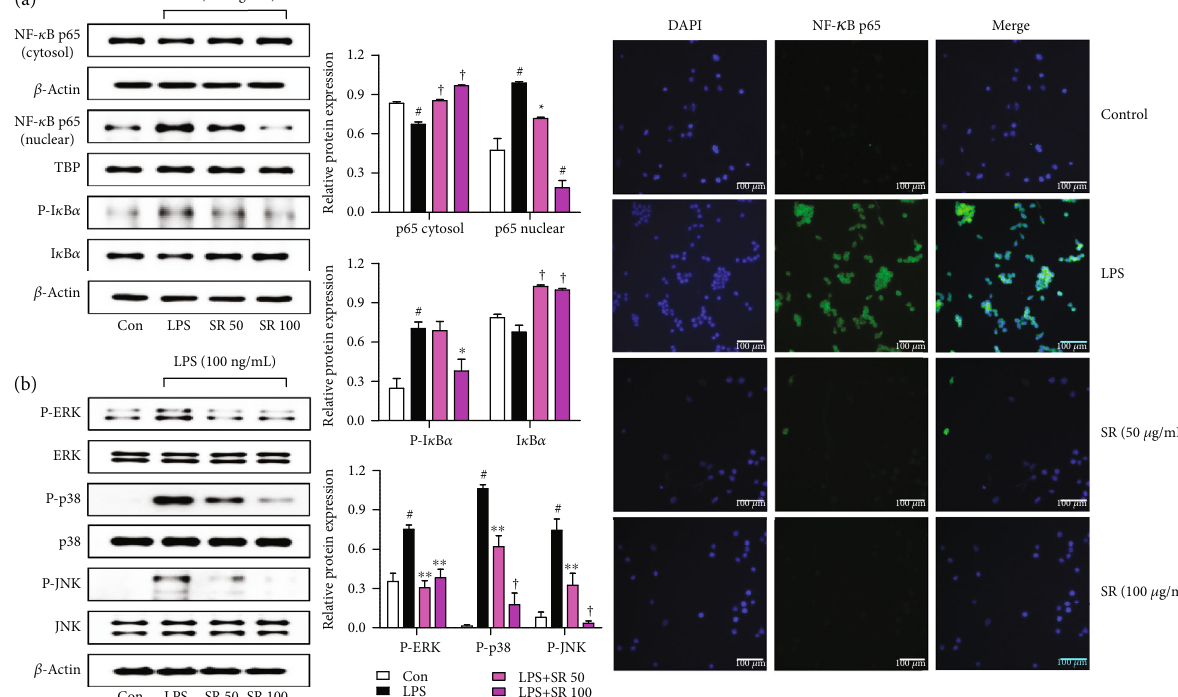
Figure 3: E ff ects of Saussureae Radix (SR) on the (a) nuclear translocation of nuclear factor- (NF-) κ B p65 and phosphorylation of inhibitor of NF- κ B alpha (I κ B α ) and (b) phosphorylation of three mitogen-activated protein kinases (MAPKs). Control cells were incubated with only fresh DMEM. Cells were stimulated with lipopolysaccharide (LPS) for 1 h (NF- κ B p65) or 30min (I κ B α and MAPK). The histogram graphs show protein expression levels relative to those of the housekeeping protein. (a) The cultured BV2 microglia were incubated with anti-NF- κ B p65 (green) and DAPI (blue). Fluorescence was developed using the Alexa Fluor 488-conjugated anti-rabbit secondary antibody. # p < 0 : 05 (vs. control); ∗ p < 0 : 05 , ∗∗ p < 0 : 01 , and † p < 0 : 001 (vs.